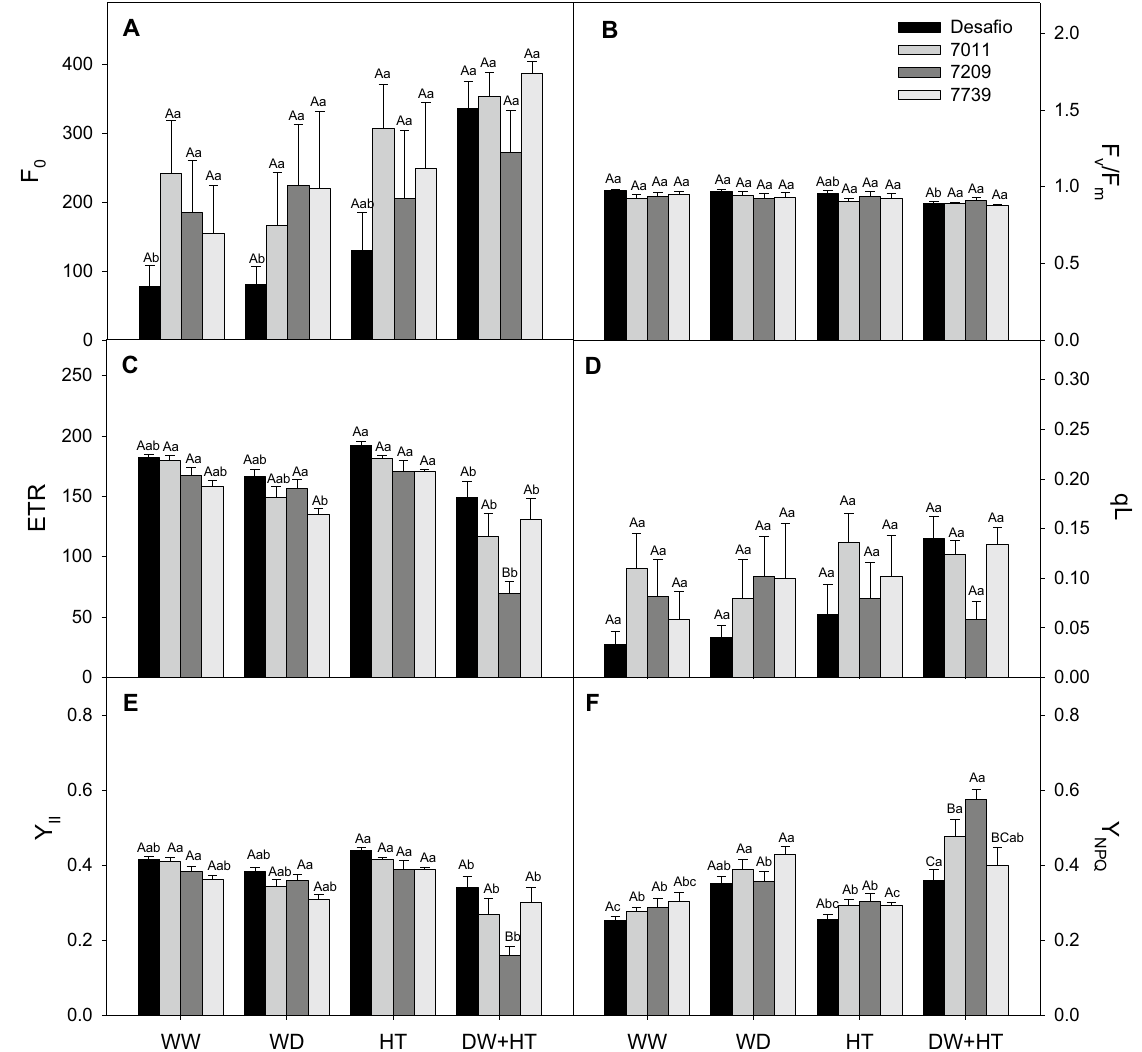
Figure 3. Photochemical parameters of soybean plants maintained for 8 days under well-watered (WW; 100% holding water capacity HWC, 25 °C), water deficit (WD; 40% HWC, 25 °C), high temperature (HT; 100% HWC, 40 °C), and water deficit plus high temperature (WD + HT; 40% HWC; 40 °C) conditions. ( A ) Minimal chlorophyll fluorescence